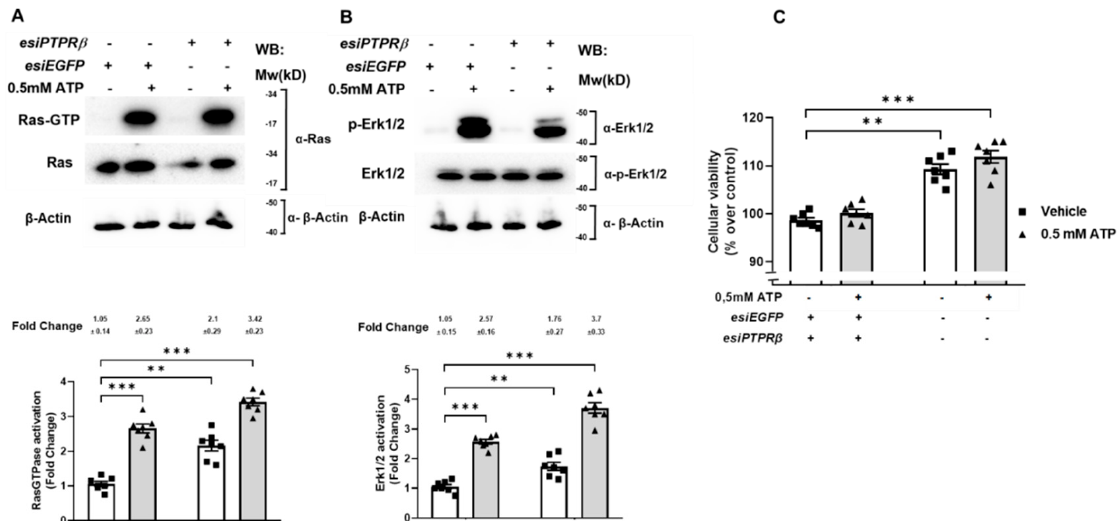
Figure 5. PTPR β controls cellular viability and Ras and Erk1/2 activation in SN4741 cells. SN4741 cells were transfected with esiPTPR β or esi EGFP as control. Twenty-four hours post-transfection, SN4741 cells were serum-starved overnight. Then, cells were treated, or not, with 0.5 mM ATP for 5 min and lysed. The cell lysates were used to measure Ras activation by the